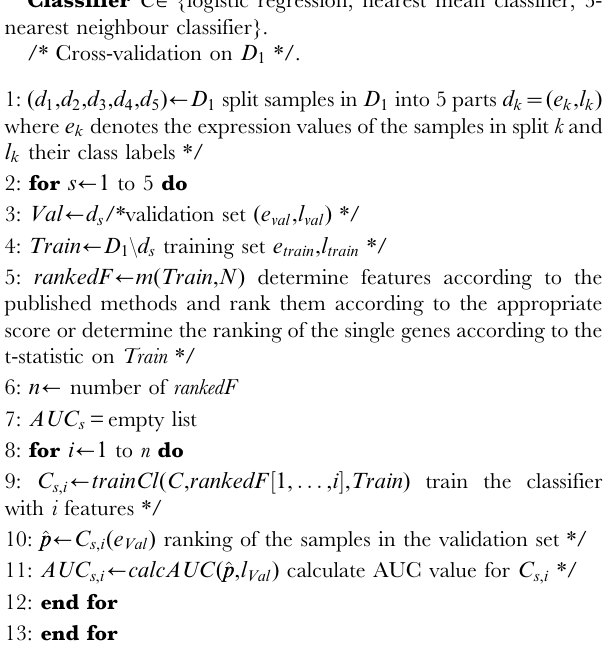
Algorithm 1. Cross-validation